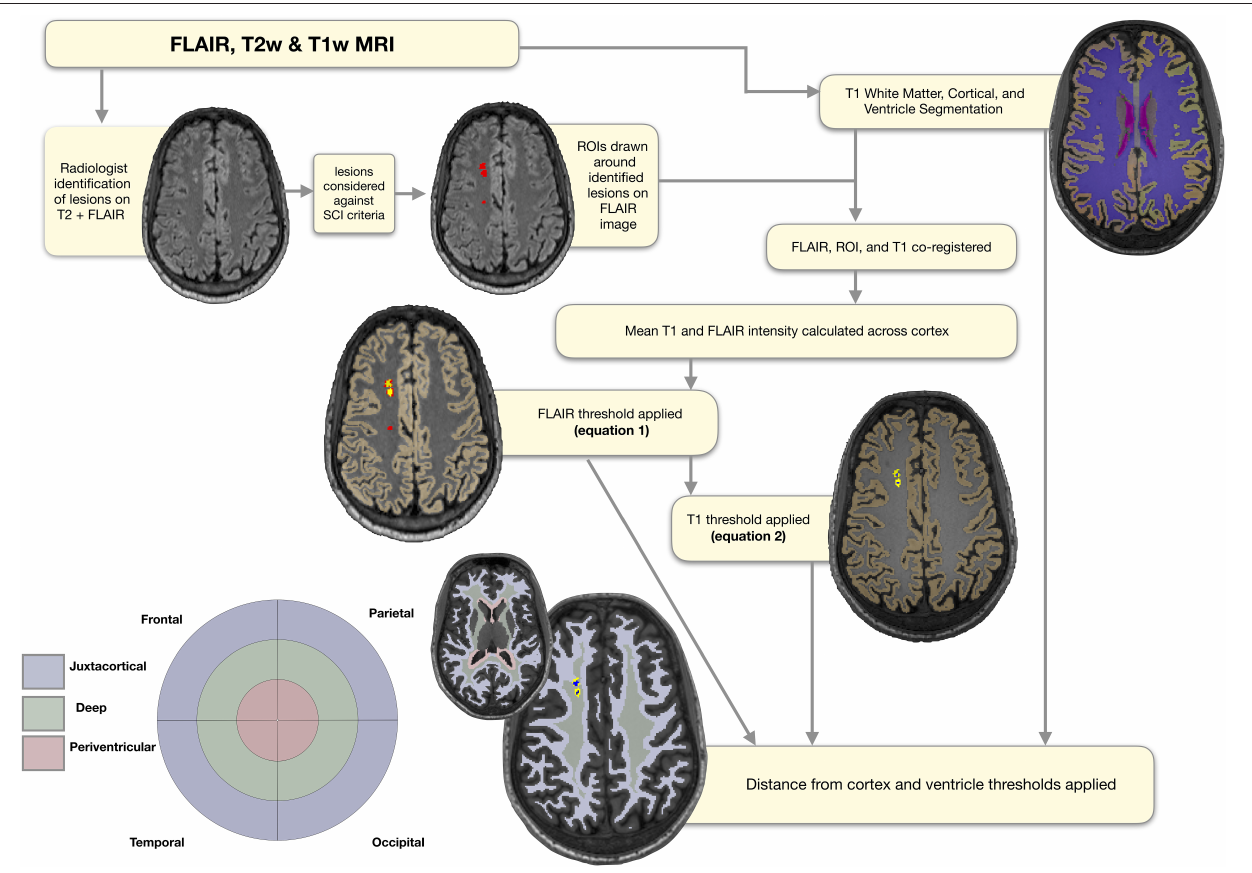
FIGURE 2 | Semi-automated pipeline. Showing regions of interest (ROIs) at each stage of the semi-automated pipeline overlaid on a FLAIR image from a representative participant with sickle cell anemia (male, 25 years old). The initial ROIs drawn around the lesions identified by the neuroradiologist are shown in red. The ROIs following application of the FLAIR threshold are shown in yellow, and the ROIs following application of the T1 threshold in blue. The masks used for regional classification, along with the corresponding simplified bullseye plot, are shown in light blue for the juxta-cortical region, light green for the deep region, and light pink for the periventricular